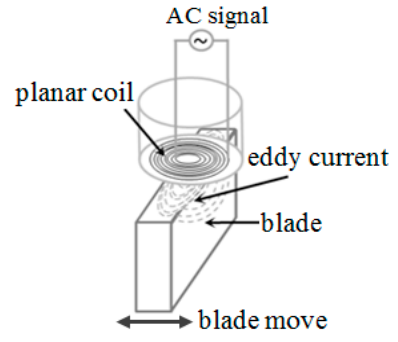
Figure 1. Schematic diagram of measuring principle.